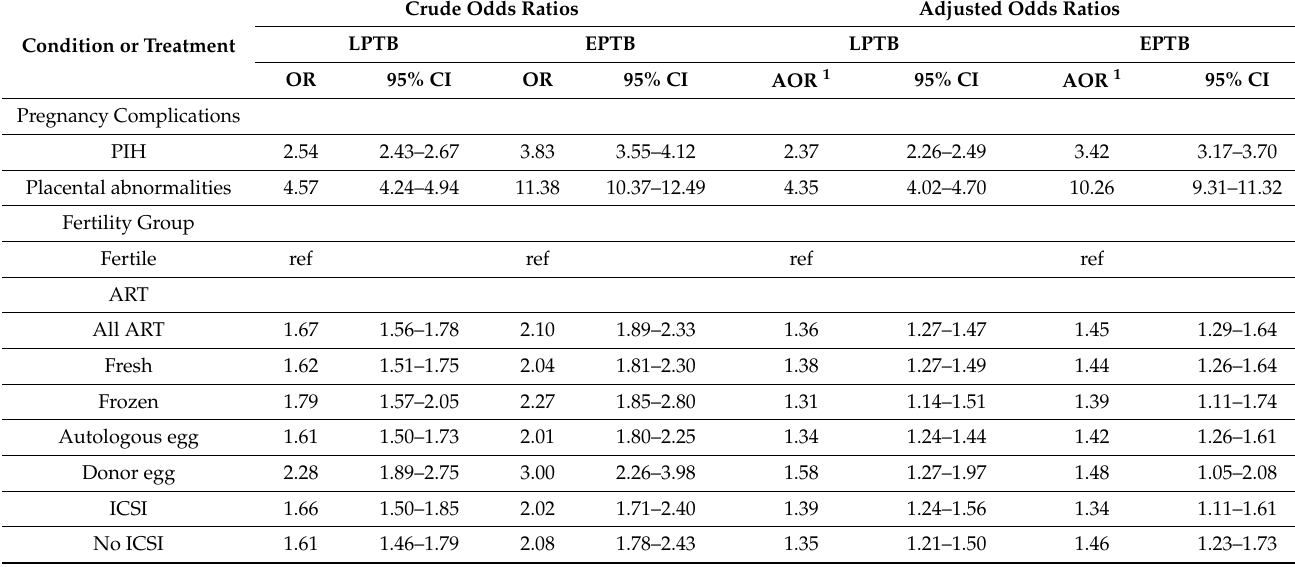
Table 2. Crude and adjusted odds ratios for ART and ART